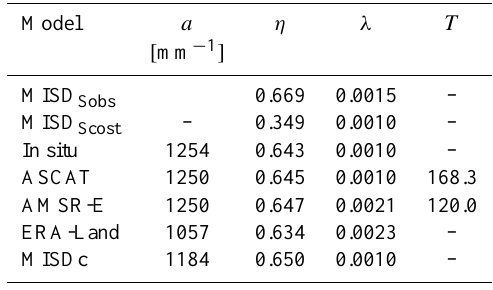
Table 3. Calibrated parameters of the models used in the study obtained from the maximization of the mean NS among all the events. MISD Sobs =MISD using “observed” initial condition S obs (obtained from inverting Eq. 3); MISD Scost =MISD model us- ing constant observed initial conditions (equal to the mean of S obs among all the selected events); in situ=model SCRRM us- ing S estimated from in situ SM measurements; ASCAT=SCRRM using S estimated from ASCAT SM measurements; AMSR- E=SCRRM using S estimated from AMSR-E SM measurements; ERA-Land=SCRRM using S estimated from ERA-Land SM mea- surements; MISDc=MISDc model (only a , η and λ are